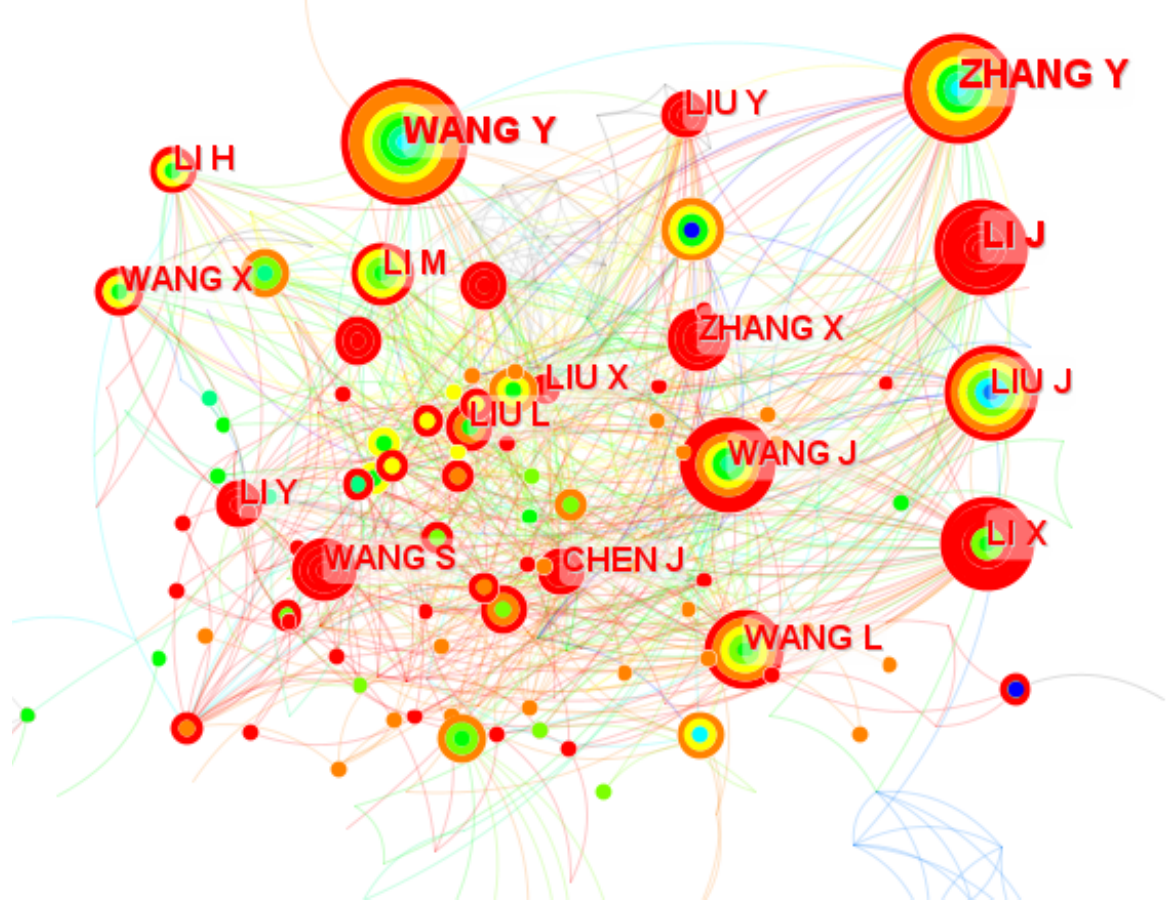
Figure 4. Institution collaboration network. Table 4. Top 10 authors based on the number of publications.